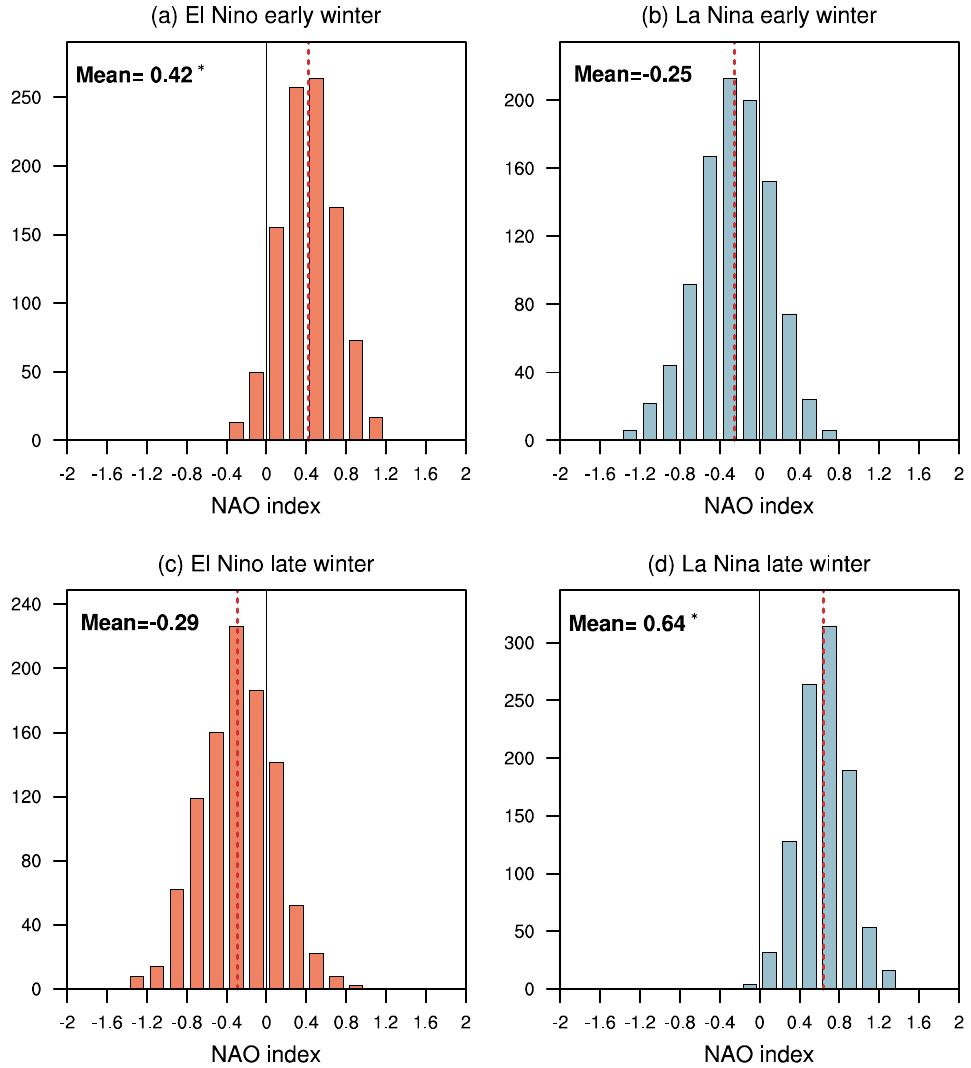
Figure 3. Histograms of the averaged NAO index after 1000 bootstrap resampling during ( a ) El Niño early winter, ( b ) La Niña early winter, ( c ) El Niño late winter, and ( d ) La Niña late winter. The bootstrap ensemble mean is displayed for each case with the asterisk denoting the value that is statistically significant at the 95% confidence level (also indicated by the dotted red line).